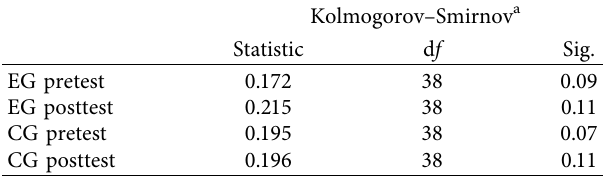
Table 1: Normality test for the scores of the pretest and